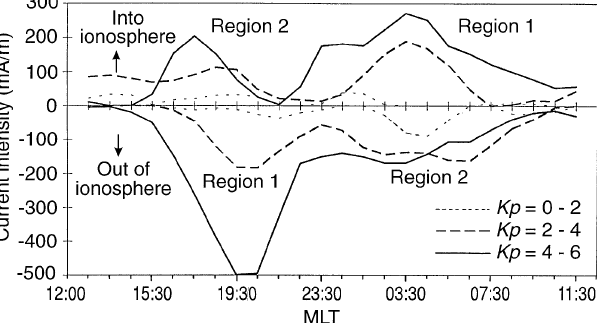
Fig. 5. Local-time variation of upward and downward current densities integrated in latitude over EISCAT field of view